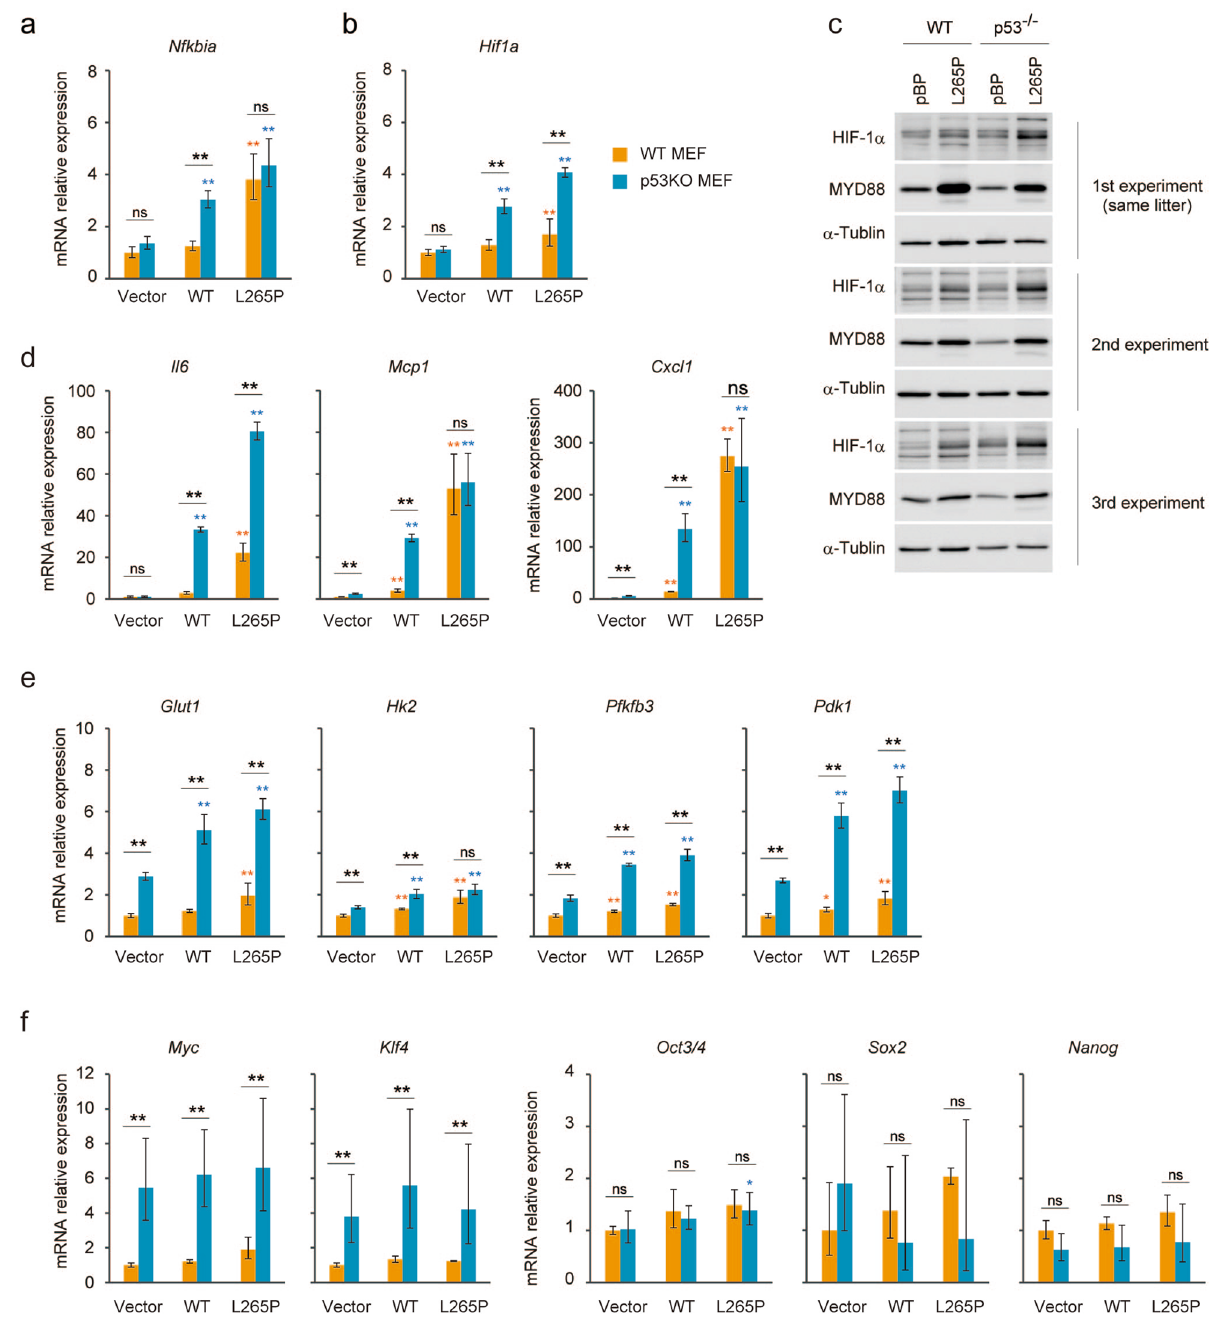
Figure 7. Deficiency of p53 promotes increased HIF-1 signalling. ( a , b , d – f ) The indicated MYD88 constructs were introduced by retroviral infection to wild type and p53 −/− MEFs. Expressions of the indicated mRNAs were measured by qPCR. The y-axis values are relative fold change for gene transcripts normalised to β-actin. The data represent the mean ± s.d. (n = 3) using one-way ANOVA followed by Scheffe’s F test. *P < 0.05, **P < 0.01. The black asterisks show significance between WT and p53 −/− MEFs. The orange asterisks show significance between indicated cells and vector introduced WT MEFs. The blue asterisks show significance between indicated cells and vector introduced p53 −/− MEFs. ( c ) WT and p53 −/− MEFs from the same litter or same background were used for this experiment. Total cell lysates were analysed by